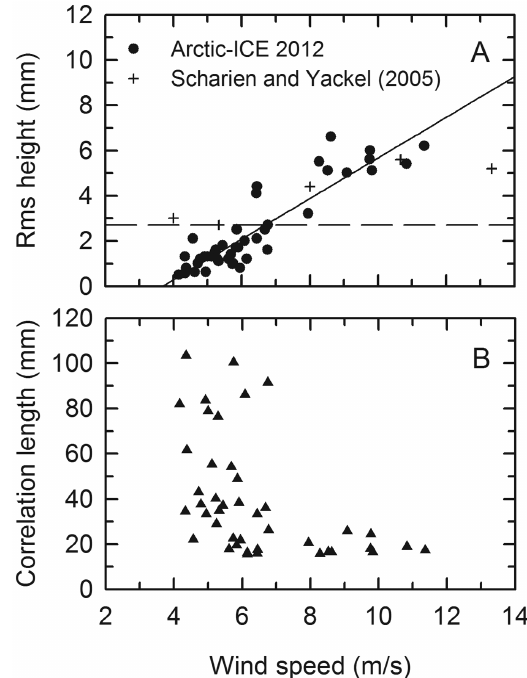
Figure 4. Wind speed ( U 10 ) dependencies of surface rms height (a) and correlation length (b) for melt ponds on level first-year sea ice. Included in (a) are rms height measurements from the wave imaging technique described in Scharien and Yackel (2005). The dashed line in (a) denotes the upper limit of the Bragg model validity range at C-band